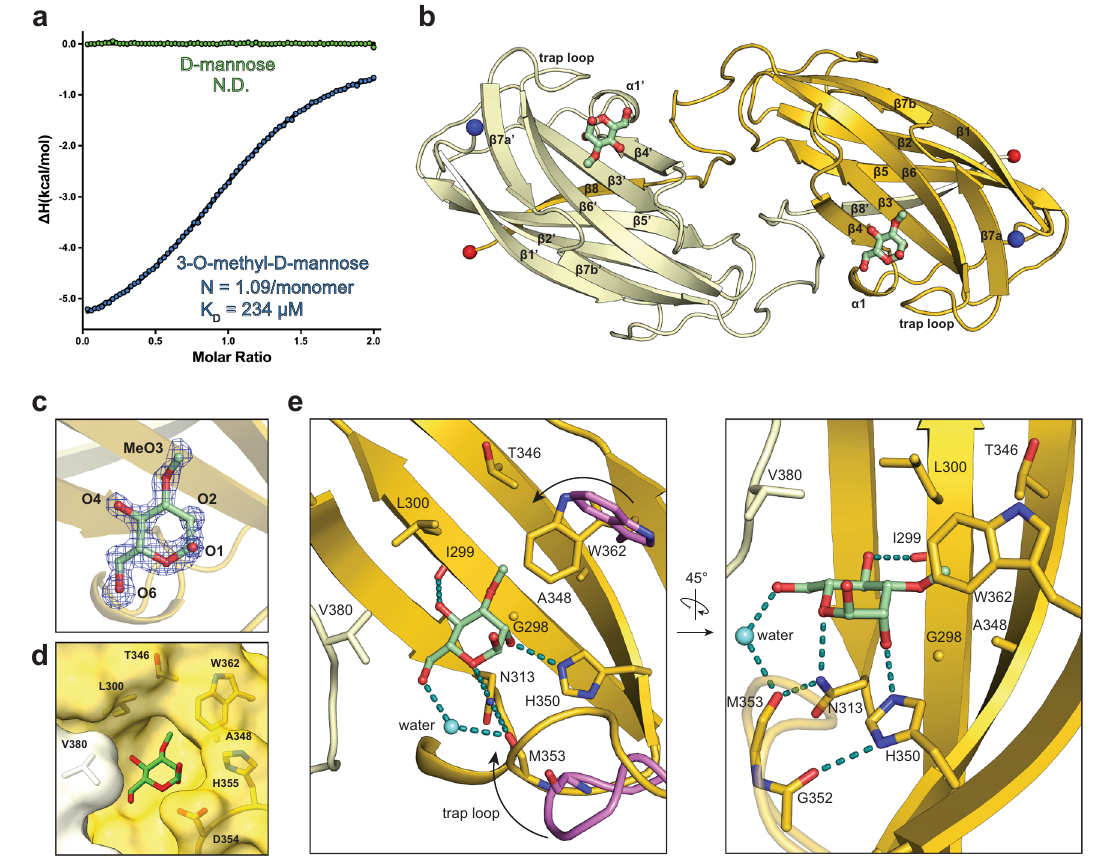
Fig. 2 | Molecular structure of Wzt-CBD bound to 3- O -methyl- D -mannose. a Isotherm plot of Wzt-CBM against 3- O -methyl- D -mannose (blue) and D -mannose (green) Raw data is provided as Source Data. b Overall structure of the Wzt-CBD dimer. Two monomers are colored separately as yellow and vanilla. 3- O -methyl- D - mannoseisshownasgreensticks.N-andC-terminalendsareshowninblueandred spheres, respectively. c Modeled 3- O -methyl- D -mannose into an unbiased F O F C map. Oxygen atoms are labeled by atom number. Mesh map was contoured at 3 σ .